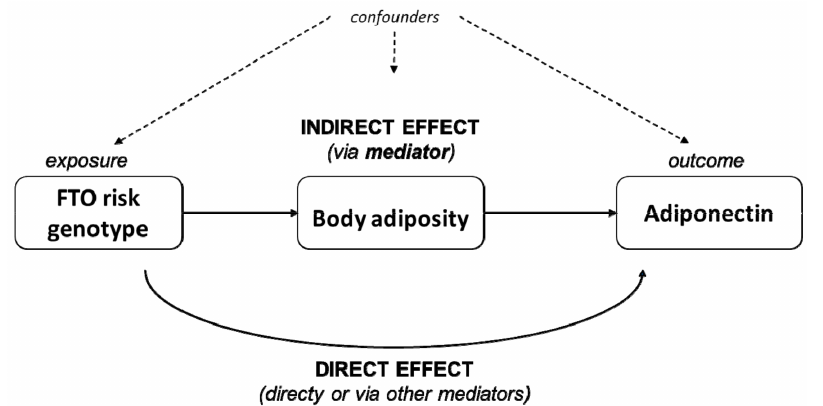
Figure 1. Schematic representation of the causal mediation analysis. The total effect of an exposure ( FTO genotype) over an outcome (concentration of circulating adiponectin) is dissected into direct and indirect effects. The indirect effect is the one being exerted via a potential mediator of interest (body adiposity). The remaining part of the effect goes directly or via mediators other than the ones under current study.